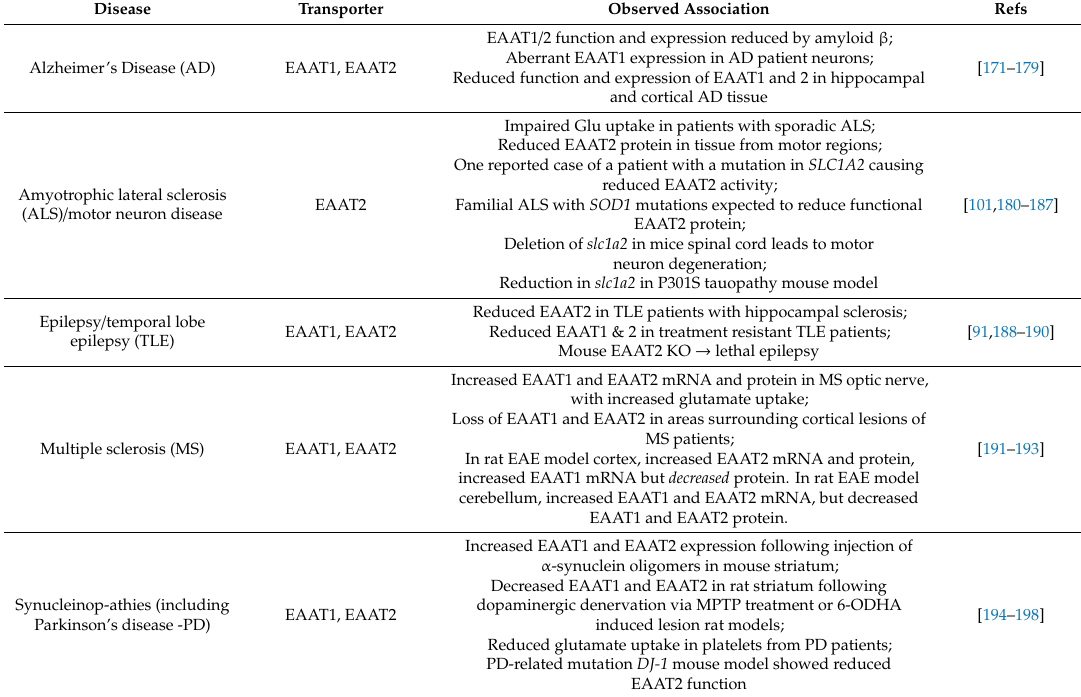
Table 3. CNS diseases and disorders associated with astrocytic glutamate transporter dysfunction. Disease